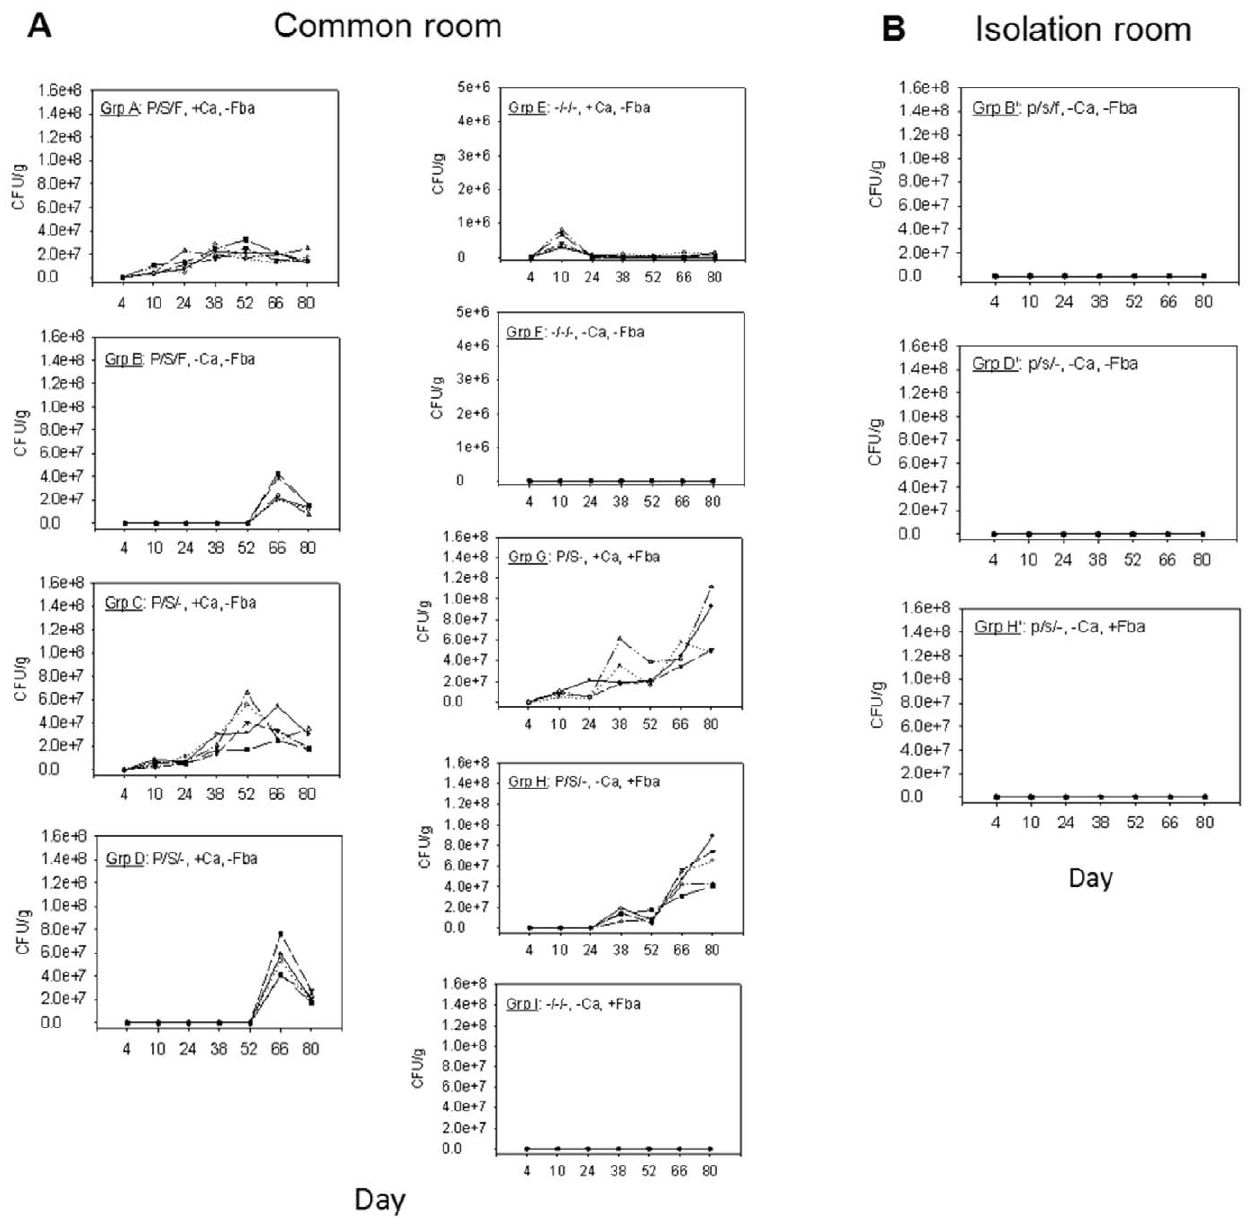
Figure 3. Confirmation of horizontal transmission of C.albicans in mice treated with antibacterial agents. Antimicrobial-treated mice not fed C. albicans (groups B, D and H) housed in a common room (Panel A) with other groups of mice intentionally colonized with the fungus ( + Ca), began showing evidence of fungal colonization by day 38 (group H) or after day 52 (groups B and D). Duplicate groups of B, D and H kept in an isolated room (i.e., groups B’, D’ and H’, respectively) did not show evidence of the fungus in their feces (Panel B). p=penicillin; s=streptomycin; f=fluconazole; + Ca= C. albicans in drinking water on days 5–9; + Fba=vaccinated with Fba starting on day 31. The various symbols on the curves represent each animal subject.